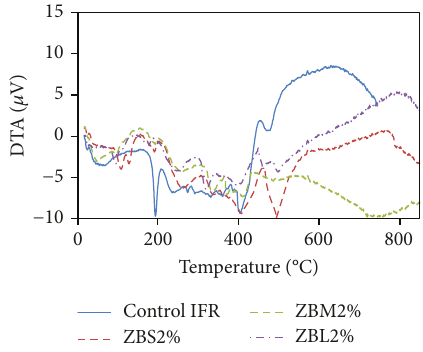
Figure 17: DTA curves of IFR/ZB coatings (under